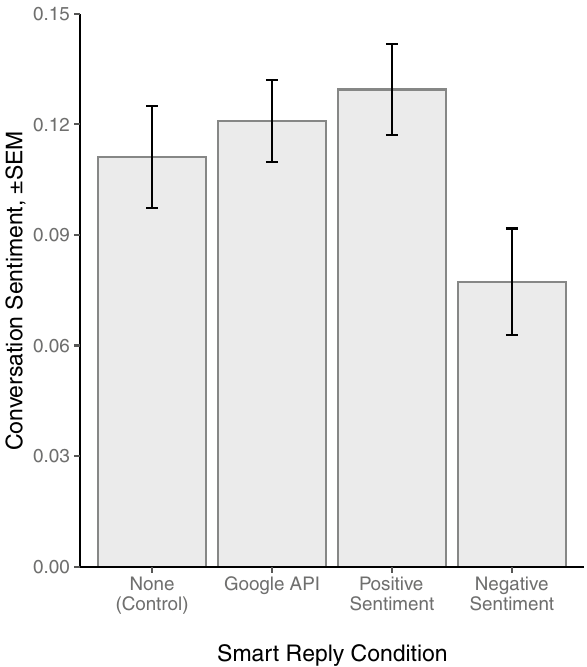
Figure 3. Mean overall conversation sentiment by experimental condition: both participants assigned to no smart replies, negative, positive, or Google smart replies. Error bars show one cluster-robust standard error above and below the